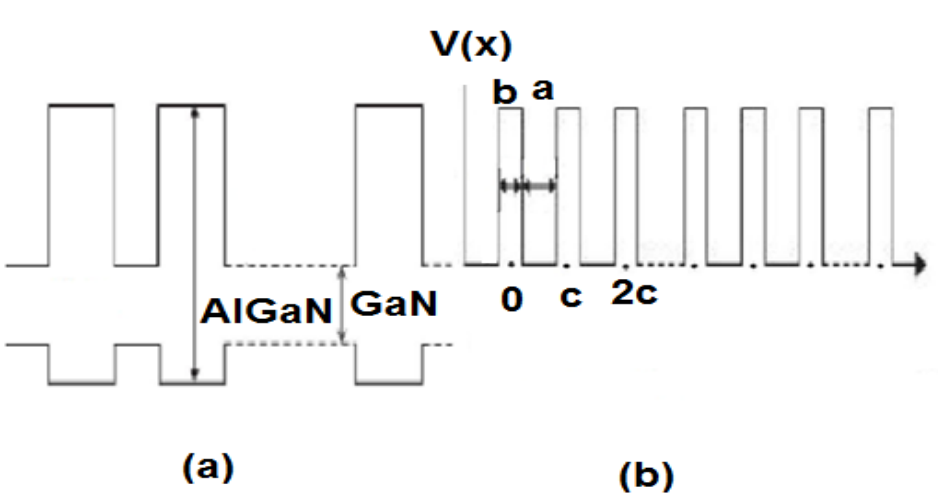
Fig. 1(a): Energy band diagram of stacking layers of GaN/AlGaN semiconducting materials (b) the multibarrier heterostructure with well and barrier regions originating from the band offset